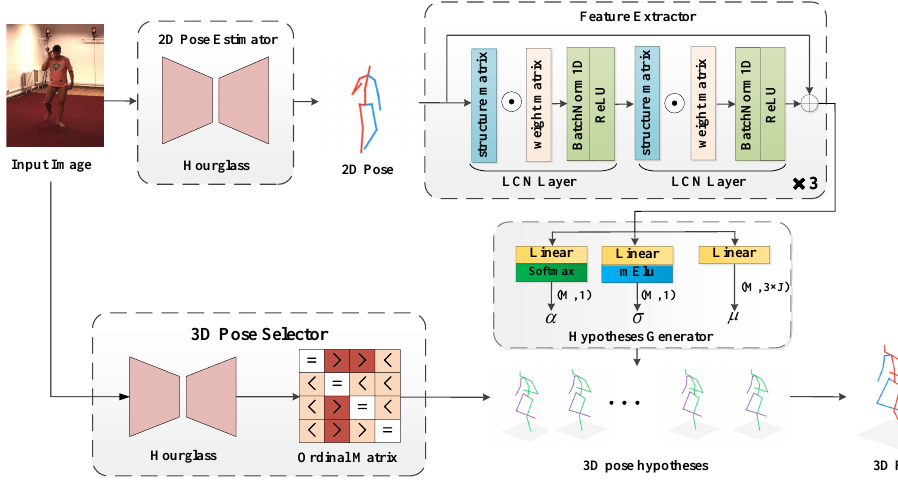
Figure 2. Illustration of the proposed Locally Connected Mixture Density Networks. The network consists of a 2D pose estimator, a feature extractor, a 3D pose hypotheses generator, and a 3D pose selector. The hypotheses generator outputs multiple hypothetical 3D poses from the detected 2D joints. The ordinal matrix is used to generate the ordinal ranking of joints to select the correct human pose estimation. M denotes the numbers of Gaussian